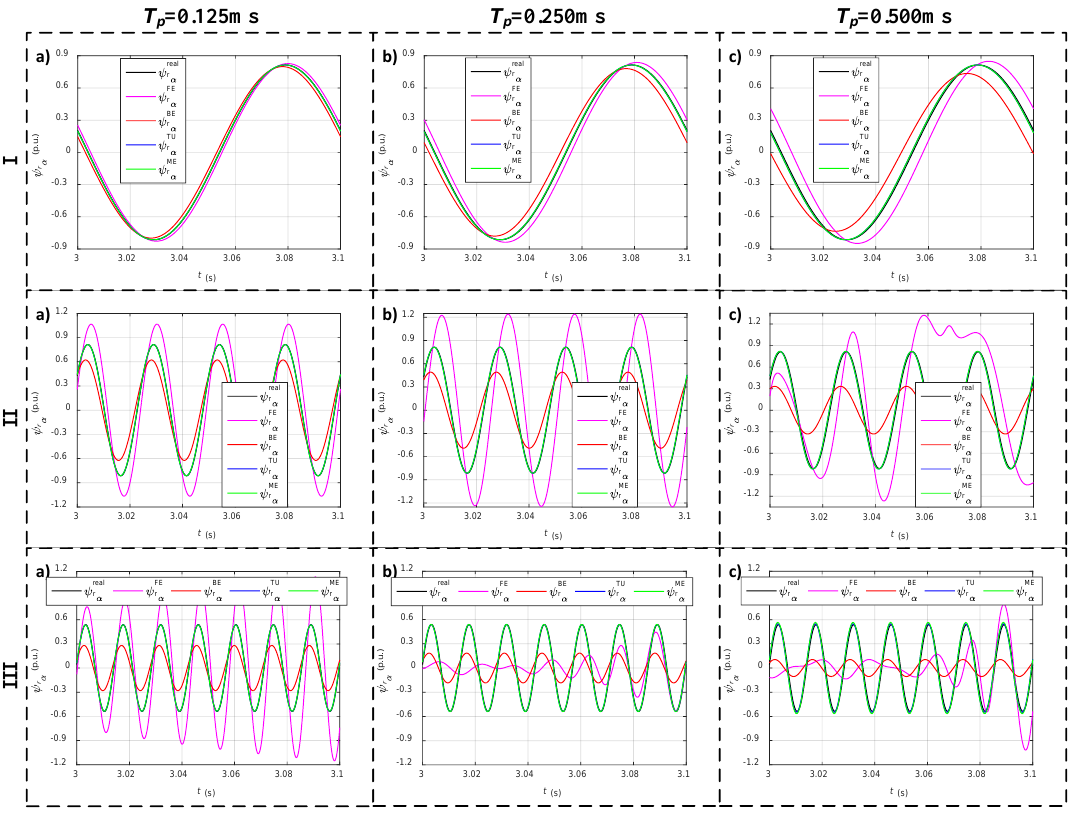
Figure 8. Rotor flux vector component in α axis after MRAS CC discretization using four numerical integration methods for three di ff erent sampling steps: ( a ) T p = 0.125 ms, ( b ) T p = 0.25 ms, ( c ) T p = 0.5 ms. Table 2. Features and properties of numerical integration methods used for the discretization of MRAS CC speed estimator. FE BE TU ME Calculation Complexity low high high medium Stability medium very good very good good Speed estimation accuracy good good very good very good low low very good very good Microprocessor implementation simple difficult difficult medium